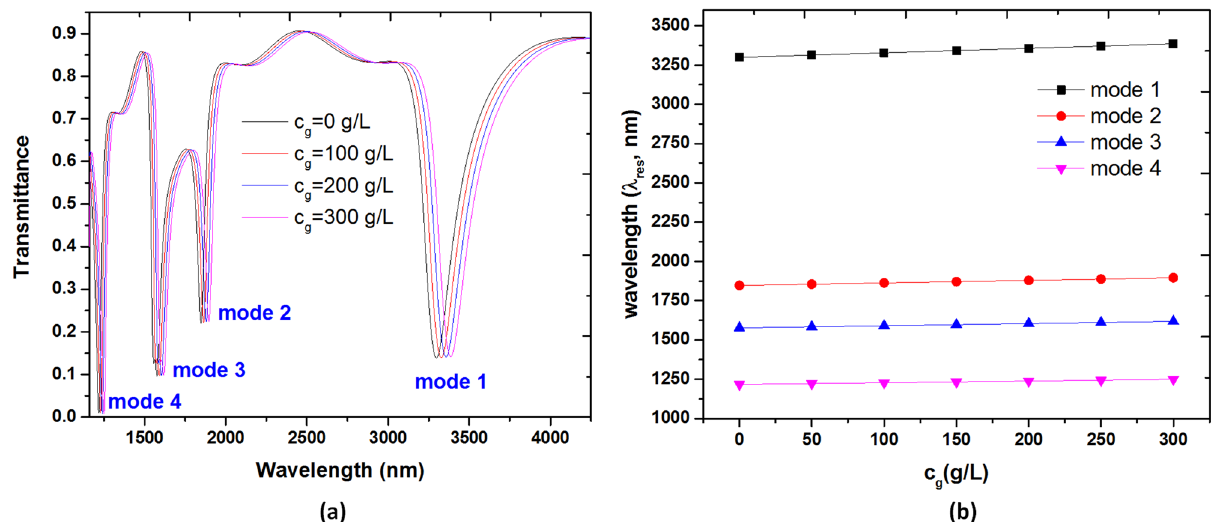
Figure 14. ( a ) Transmittance spectrum of the solution in case 3 structure from mode 1 to mode 4 when the glucose concentration, c g , varies from 0 g/L, 100 g/L, 200 g/L to 300 g/L, respectively. ( b ) Calculated resonance wavelength (λ res ) from modes 1 to mode 4 versus the glucose concentration ( c g ) range from 0 to 300 g/L. The structural parameters are the same as Fig.